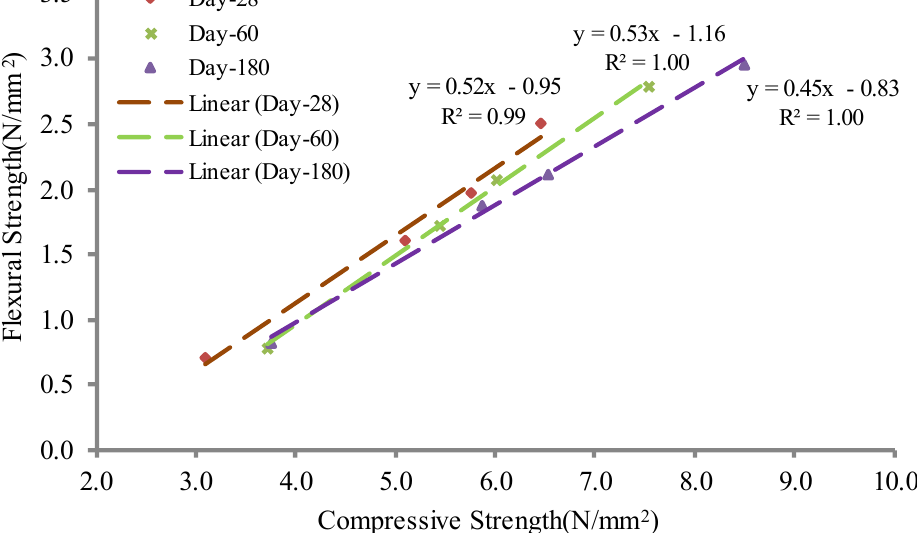
Figure 13. Correlation between foamcrete compressive and flexural